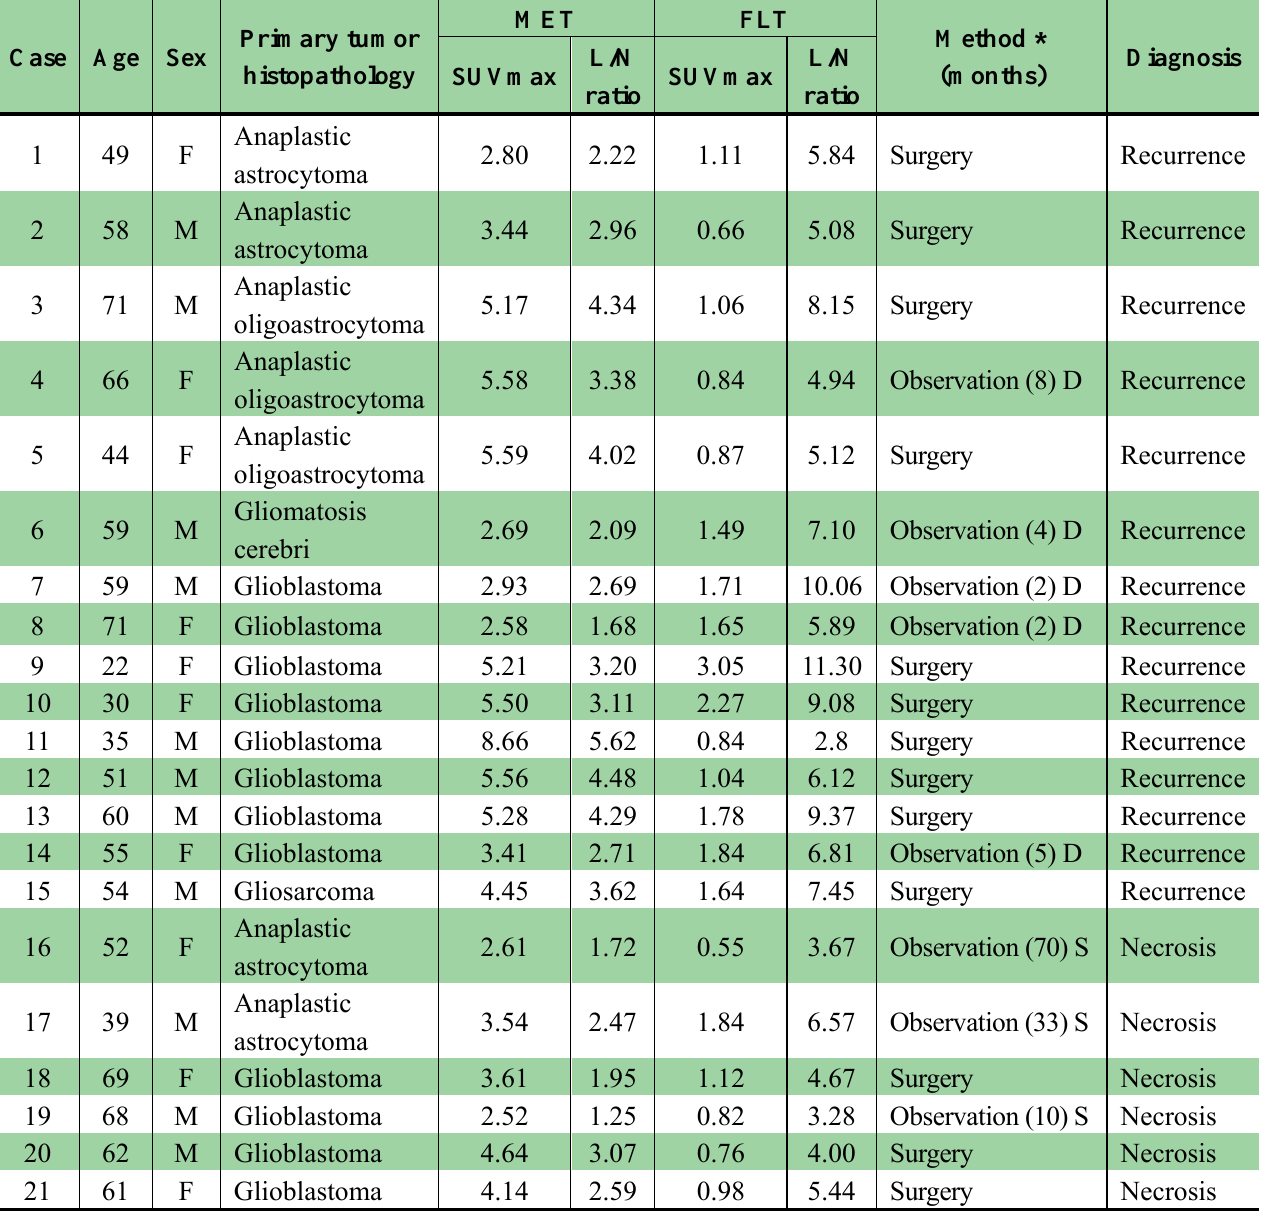
Table 1. Summary of demographic and imaging data of the